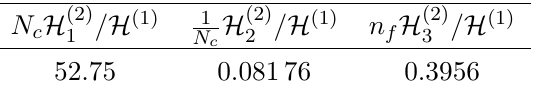
Table 3 . Numerical values for the components of the two-loop hard function normalised to the one-loop hard function defined in eq. (6.2) at the benchmark point of eq. (6.3). Values are quoted with N c = 3 and n f = 5 , to four significant figures.